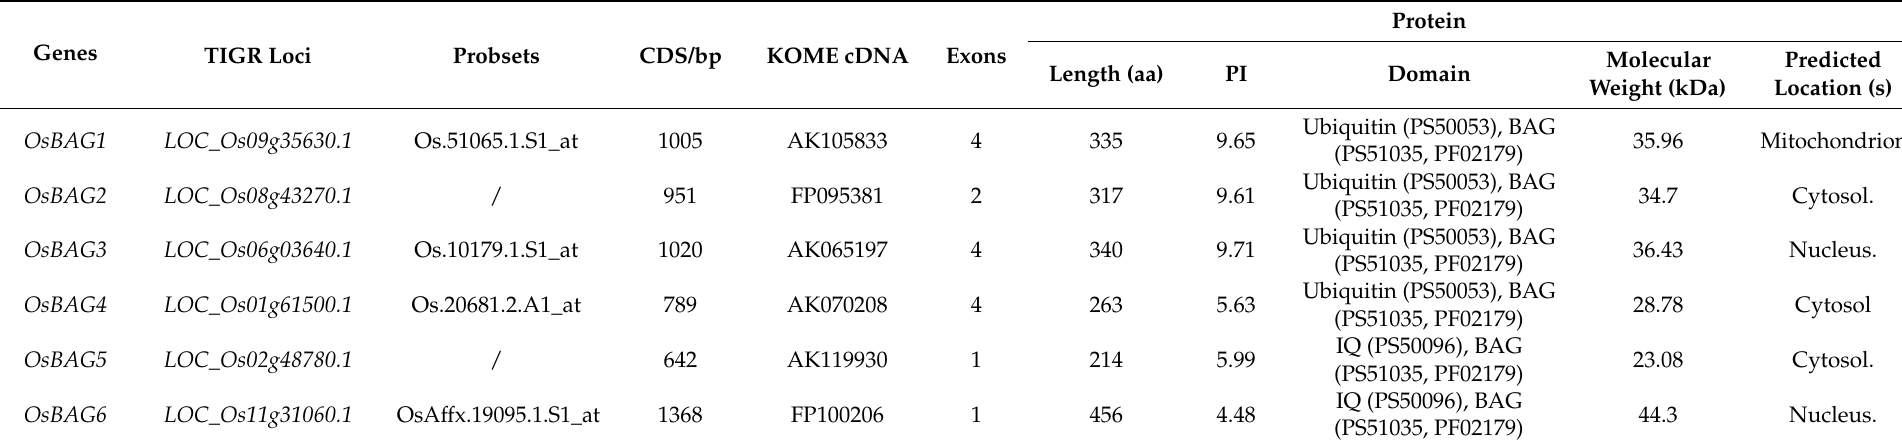
Table 1. List of the six OsBAG genes identified in